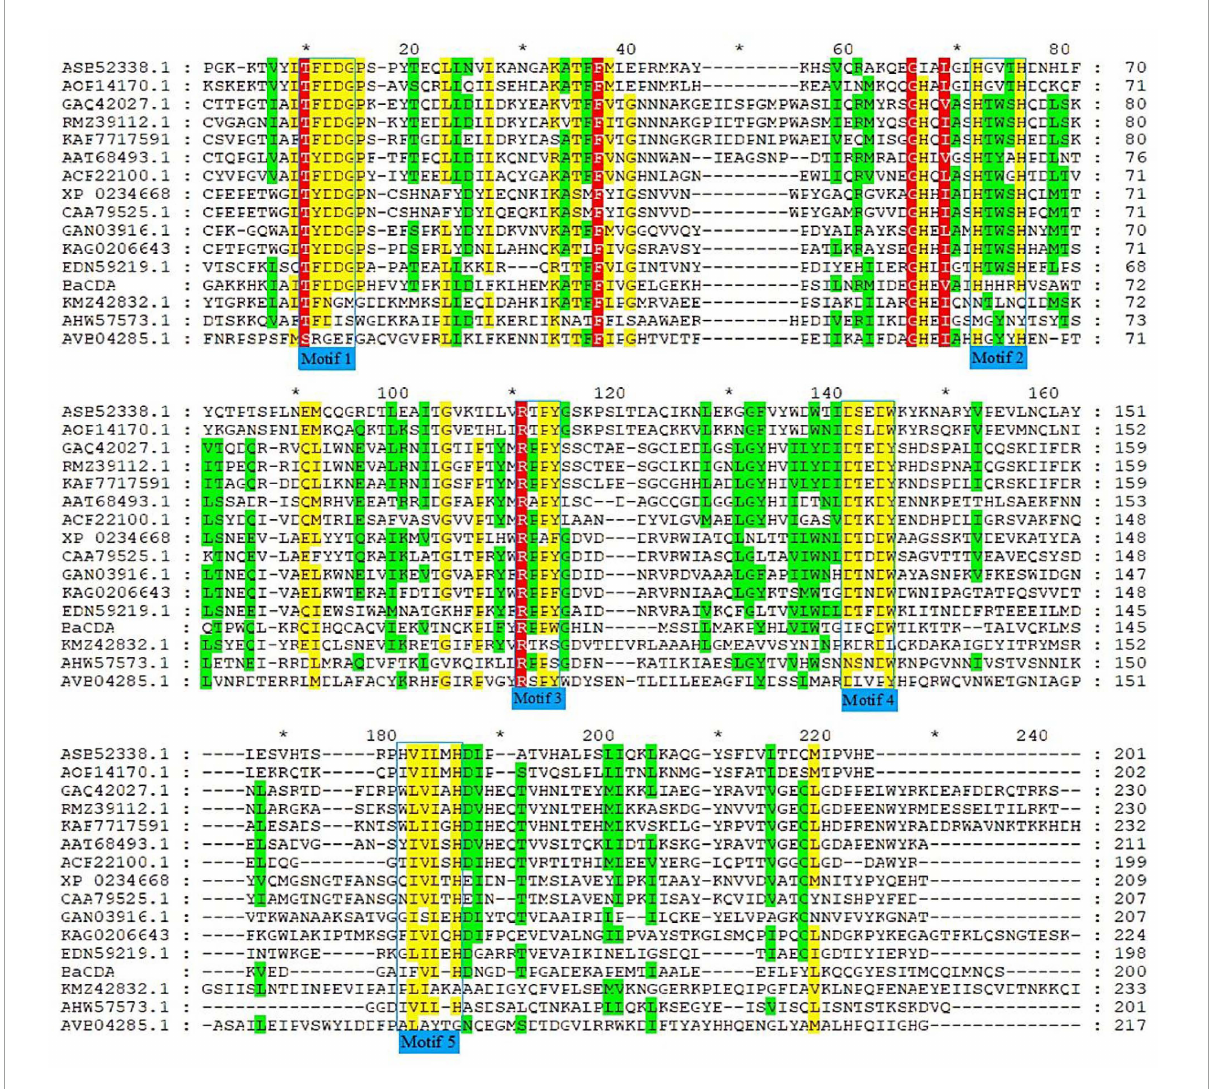
FIGURE8 Amino alignment of CDA from several microorganisms. Amino acid sequences of CDAs from Penicillium sp . RFL-2021a (KAF7717591.1), Salmonella enterica (AVB04285.1), Amylomyces rouxii (CAA79525.1), Colletotrichum lindemuthianum (AAT68493.1), Aspergillus niger (GAQ42027.1), Bacillus cereus (AHW57573.1), Aspergillus nidulans (ACF22100.1), Bacillus licheniformis (AOP14170.1), Mortierlla sp. GBA30(KAG020643.1), Aspergillus flavus (RMZ39112.1), Bacillus velezensis (ASB52338.1), Saccharomyces cerevisiae YJM789 (EDN59219.1), Bacillus sp. FJAT-27238 (KMZ42832.1), Mucor ambiguus (GAN03916.1), and Rhizopus microspores ATCC52813 (XP_023466809.1) were aligned. Identical or highly conserved residues are shaded in red, while similar residues are shaded in yellow or green. The catalytic domains with five conserved motifs 1 ∼ 5 were framed by the blue